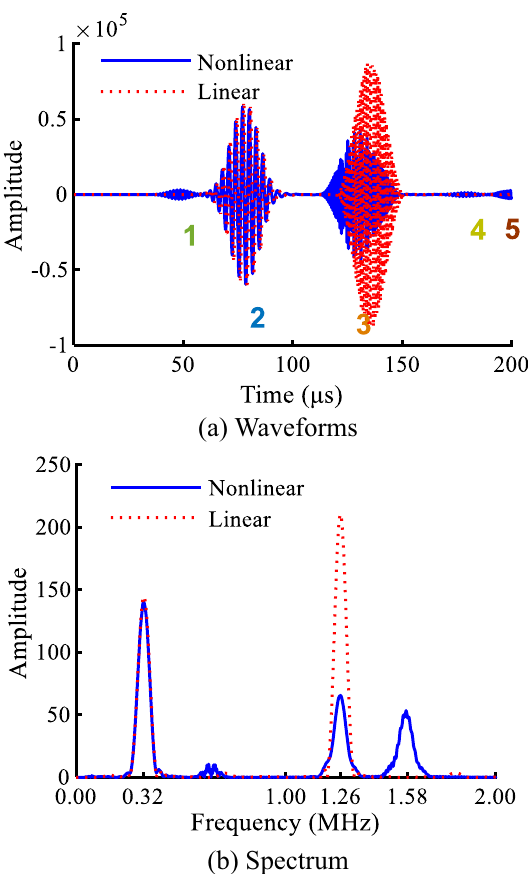
Figure 5 Waveform and spectrum obtained from two models at point 1